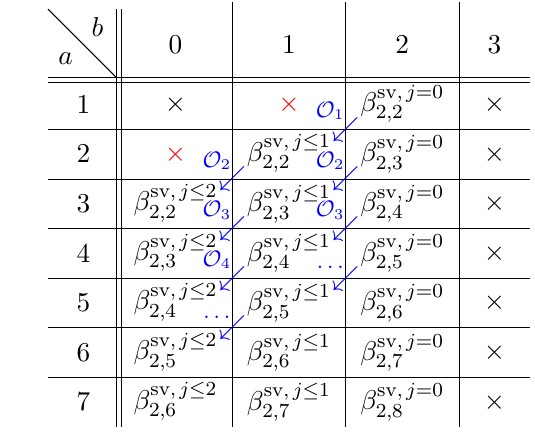
(4 , 0 b ) , together with 0